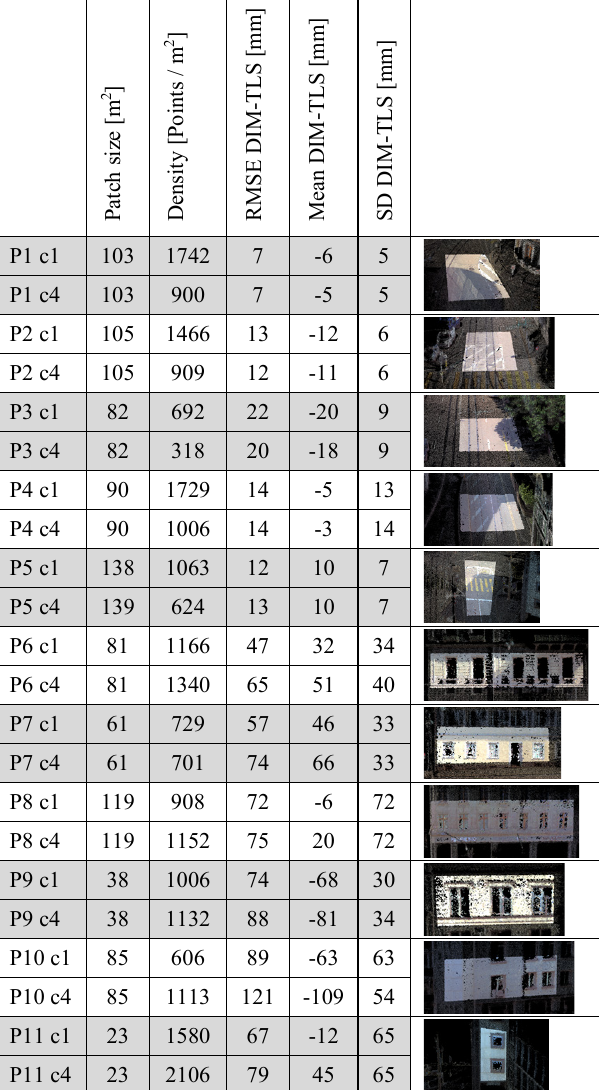
Table 7. Density and deviation values for all road and façade patches by SURE 1 match image (configuration 1, c1)